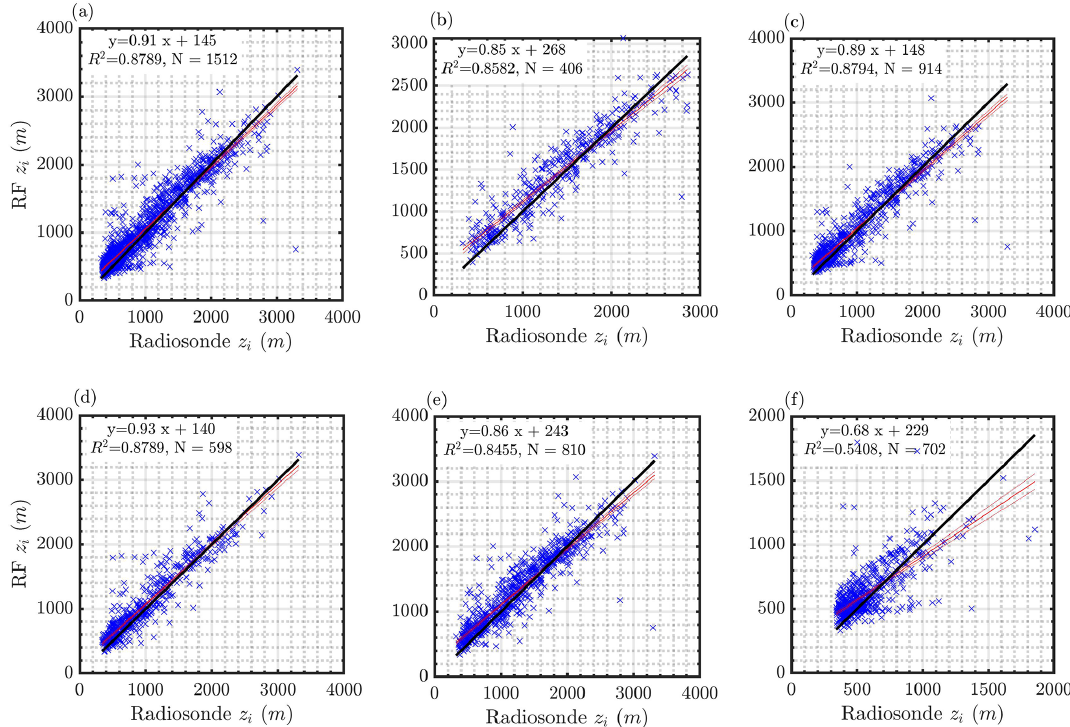
Figure 5. Correlations between RF PBL height and radiosonde PBL height for (a) all data in 2019, (b) daytime clear sky, (c) clear-sky daytime and nighttime, (d) cloudy daytime and nighttime, (e) daytime only, and (f) nighttime